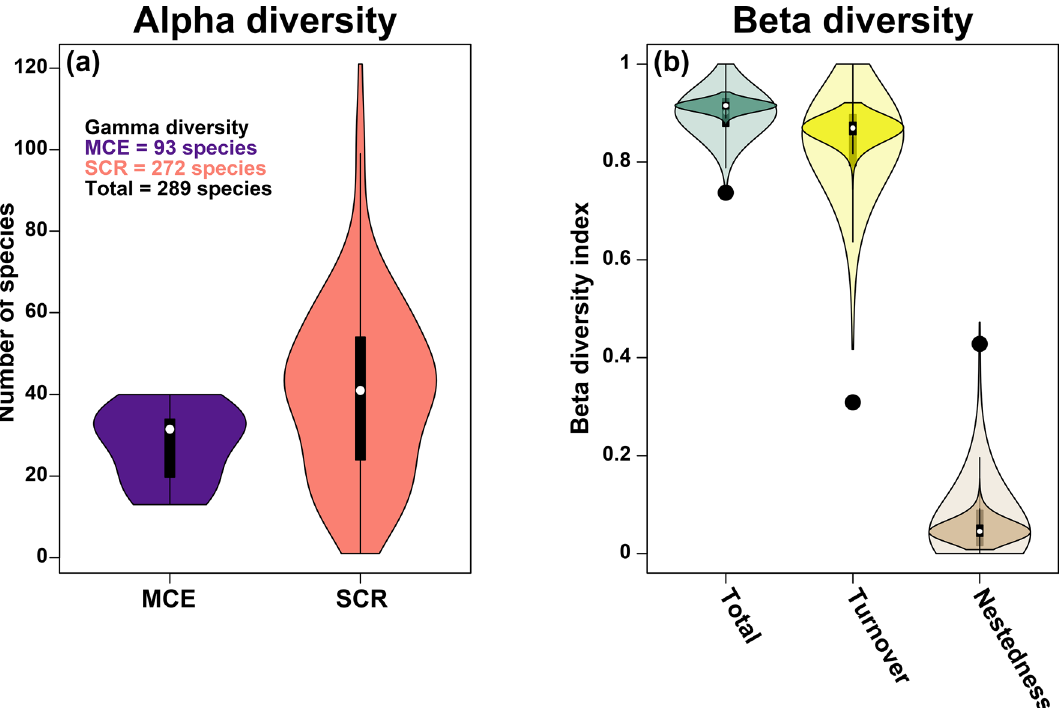
Figure 3. ( a ) Alpha diversity at MCE sites (30–70 m) and SCR sites (0–30 m). ( b ) Beta diversity including turnover and nestedness comparing MCE and SCR sites. Black points represent the beta diversity for the single pairwise comparison, the light-colored areas represent the beta diversity calculated with the bootstrapped pairwise comparison from each group, and the dark colored areas represent the bootstrapped multiwise comparison from each